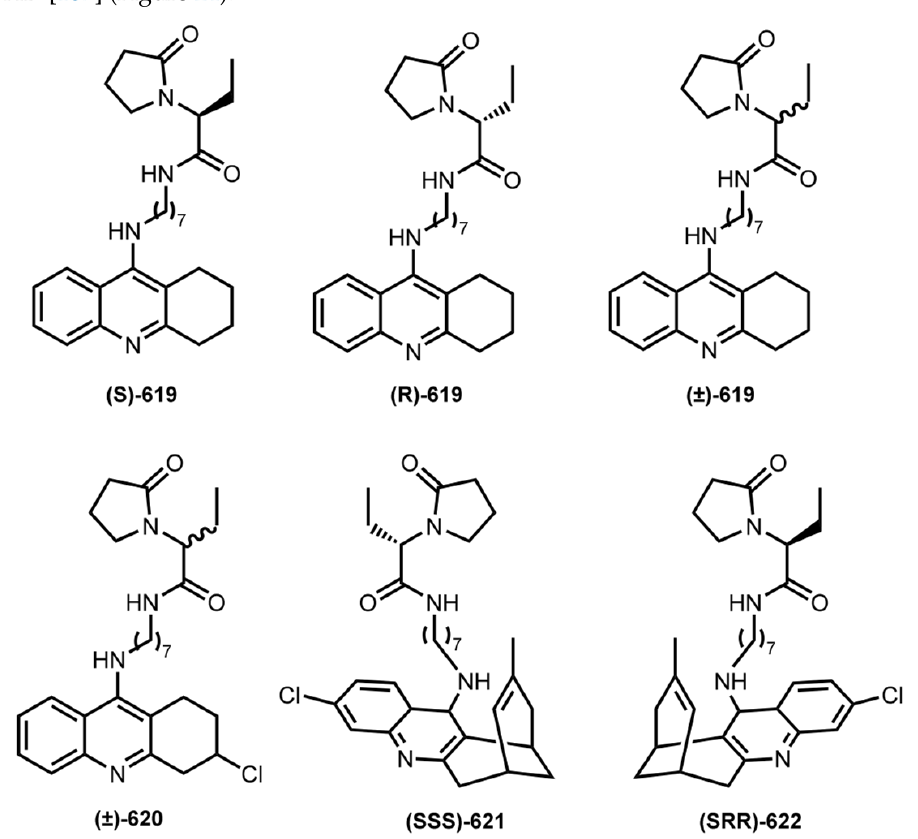
Figure 24. THA (S)-619 , (R)-619 , ( ± )-619 , 6-Cl-THA ( ± )-620 , huprine Y (SSS)-621 , and (SRR)-622 – Figure 24. THA (S) ‐ 619 , (R) ‐ 619 , (±) ‐ 619 , 6 ‐ Cl ‐ THA (±) ‐ 620 , huprine Y (SSS) ‐ 621 , and (SRR) ‐ 622 – based hybrids with 2-(2-oxopyrrolidin-1-yl)butyramide moiety of levetiracetam [99]. based hybrids with 2 ‐ (2 ‐ oxopyrrolidin ‐ 1 ‐ yl)butyramide moiety of levetiracetam [99]. All hybrids were potent inhibitors of hAChE, with IC 50 in the low nanomolar range. Huprine is a stereoactive drug, with (7R,11R)-huprine derivatives being more potent hBuChE inhibitors than (7S,11S)-counterparts [188]. Expectedly, 621 and 622 showed different inhibition activity. However, no differences in inhibitory activity of (7S,11S)- huprine Y hybrids were detected. Hybrids 621 and 622 exhibited a moderately potent A β 42 and tau antiaggregating activity. The inhibition of mouse brain AChE after i.p. administration of the levetiracetam-based hybrids was also confirmed. A significant reduction in the frequency of spontaneous convulsions in APP/PS1 mice treated with the levetiracetam-huprine hybrid 621 was revealed. APP/PS1 mice treated with hybrids 619 and 621 exhibited significantly increased recognition indices when compared to vehicle- treated animals. In addition, immunohistochemical determination revealed a reduction of the A β burden in the cortex of APP/PS1 mice after chronic treatment with 621 . Finally, chronic treatment with 621 led to a significant reduction of GFAP positive astrocytes around A β plaques and Iba1 positive microglial cells in APP/PS1